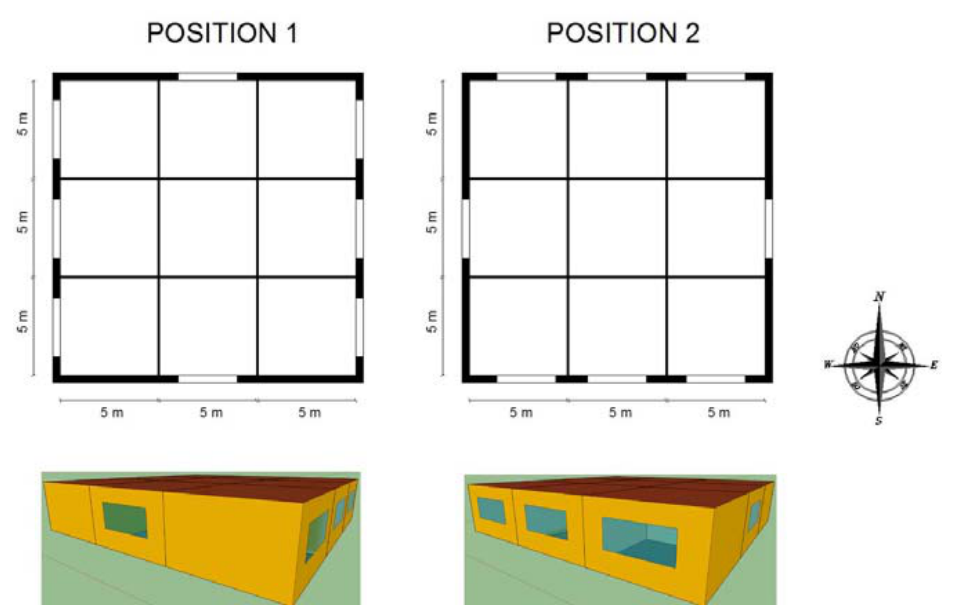
Figure 3. Evaluation of the windows: Position 1 and Position 2.